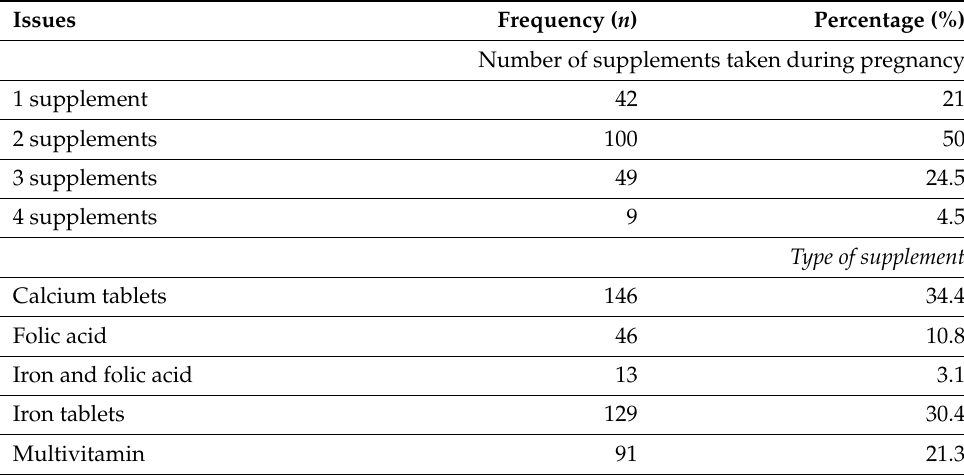
Table 3. Supplements that were currently taken during pregnancy by the users.